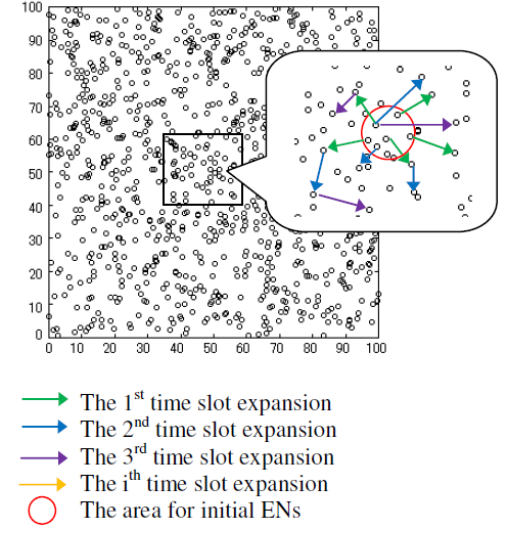
Figure 9. Single-event model with the initial ENs that adequately covers a circle area 2 } to generate the { (x − 10) 2 + (y − 10) 2 = R circle